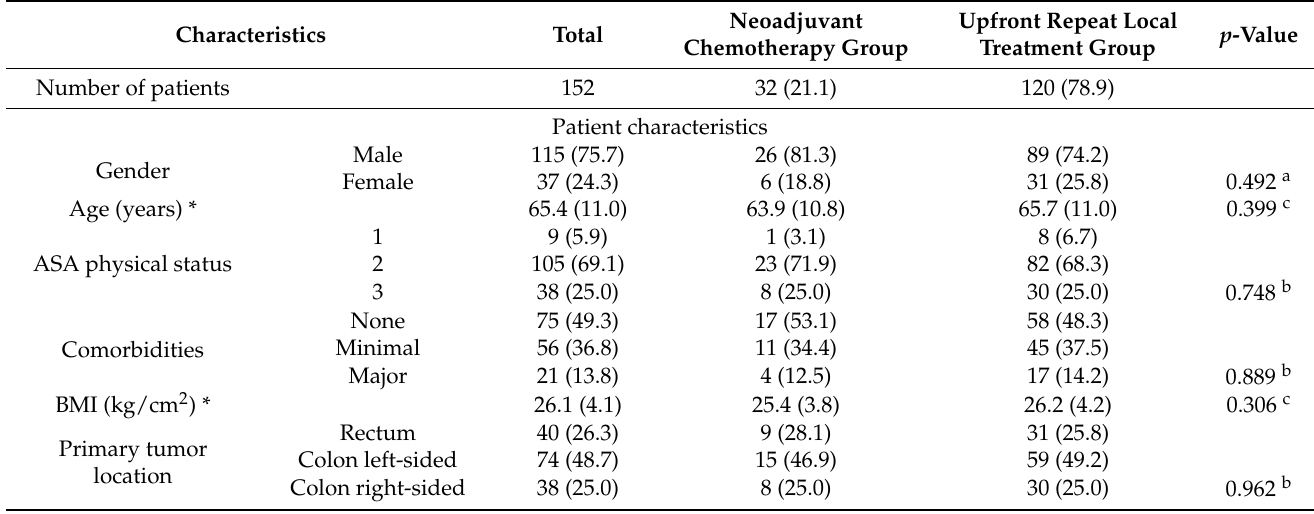
Figure 1. Flowchart of included and excluded patients. Table 1. Baseline characteristics at recurrent